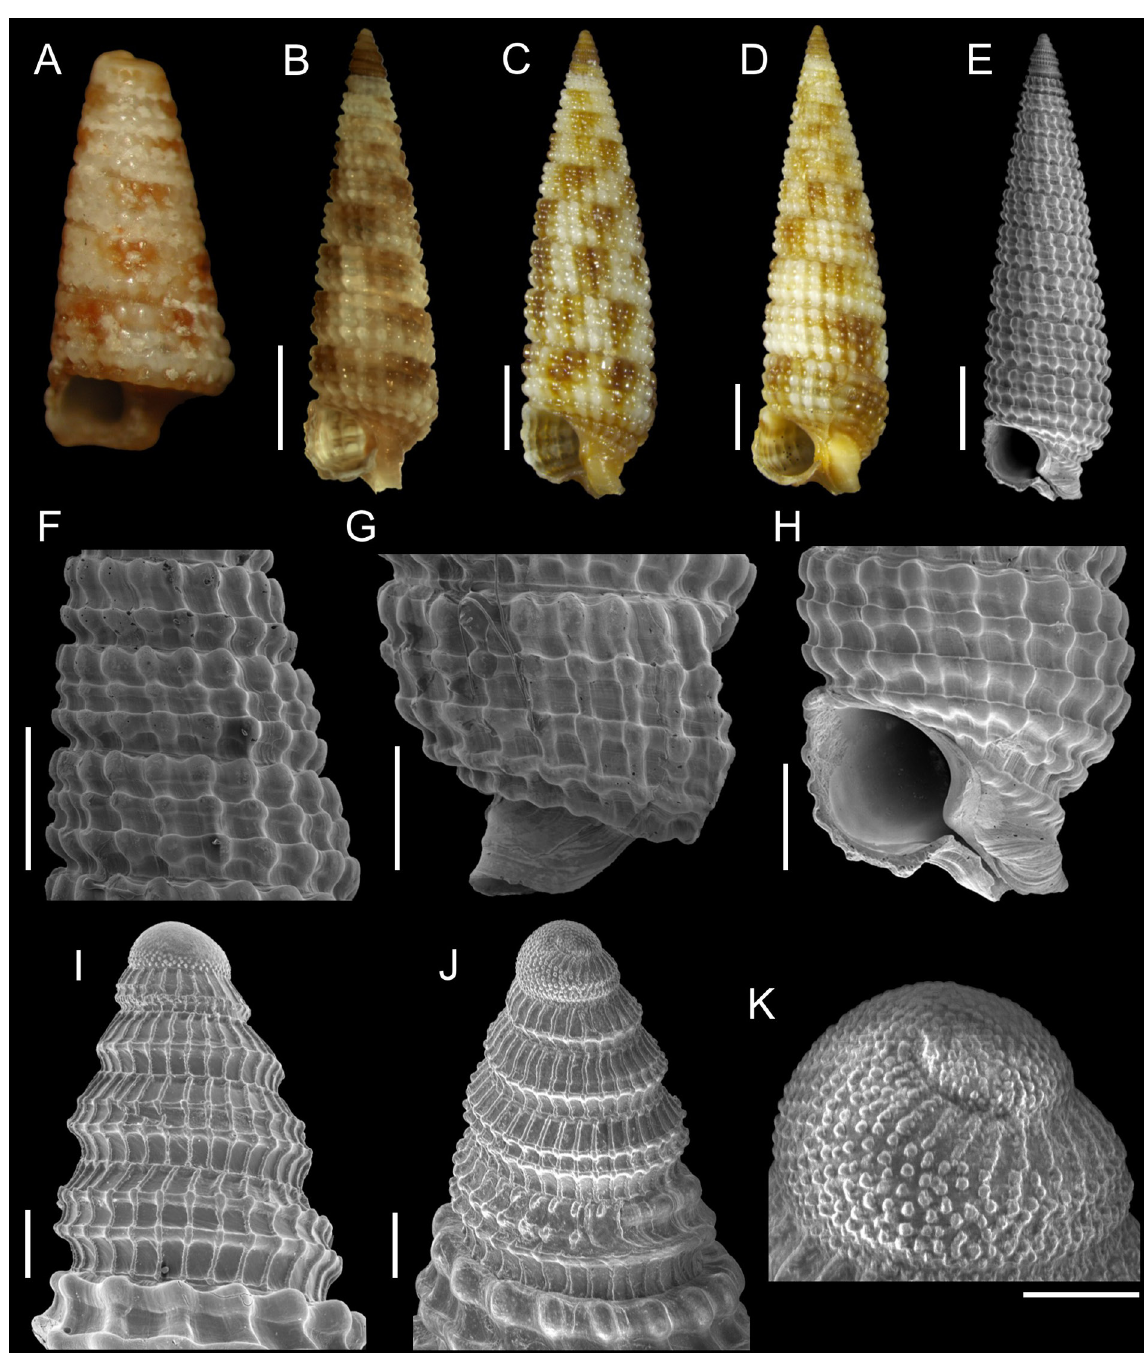
Fig. 92. Nototriphora decorata (C.B. Adams, 1850). A . Lectotype, MCZ 186178. B . MNRJ 18410*, 4.47 mm. C . MNRJ 18954*, 5.53 mm. D . MNRJ 34109*, 7.12 mm. E . MNRJ 17990*, 5.61 mm. F–H . Same shell as E. I . MNRJ 18398*. J–K . Same shell as C. Scale bars: B–E = 1 mm; F–H = 500 µm; I–J = 100 µm; K = 50 µm